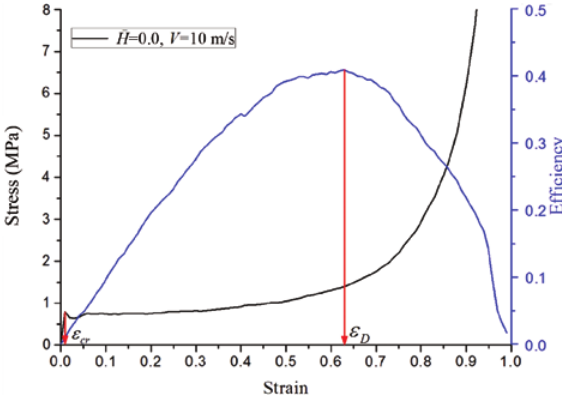
Figure 7: Capture of the densification strain.